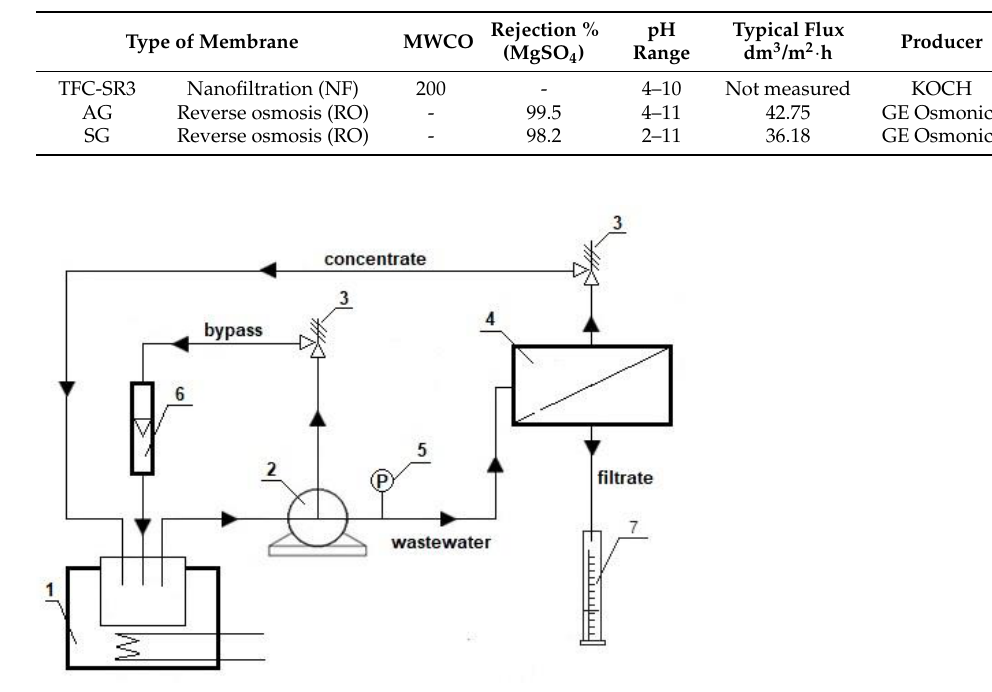
Figure 2. Schematic diagram of the nanofiltration system: 1 — thermostat; 2 — pump; 3 — control valves; 4 — pressure chamber with the membrane; 5 — manometer; 6 — rotameter; 7 — measuring cylinder. Table 2. Comparison of the NF and the RO membranes.